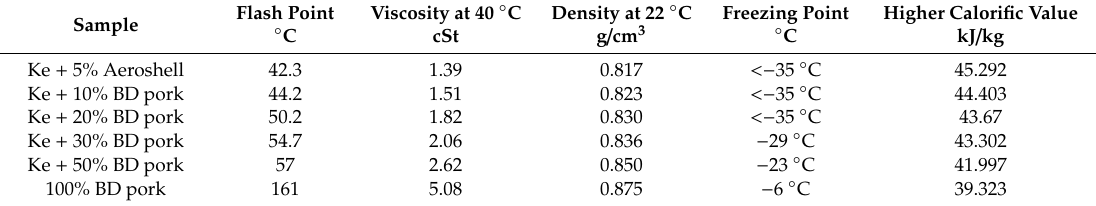
Table 1. Experimental results for physical-chemical properties for fuel blends. BD, biodiesel.